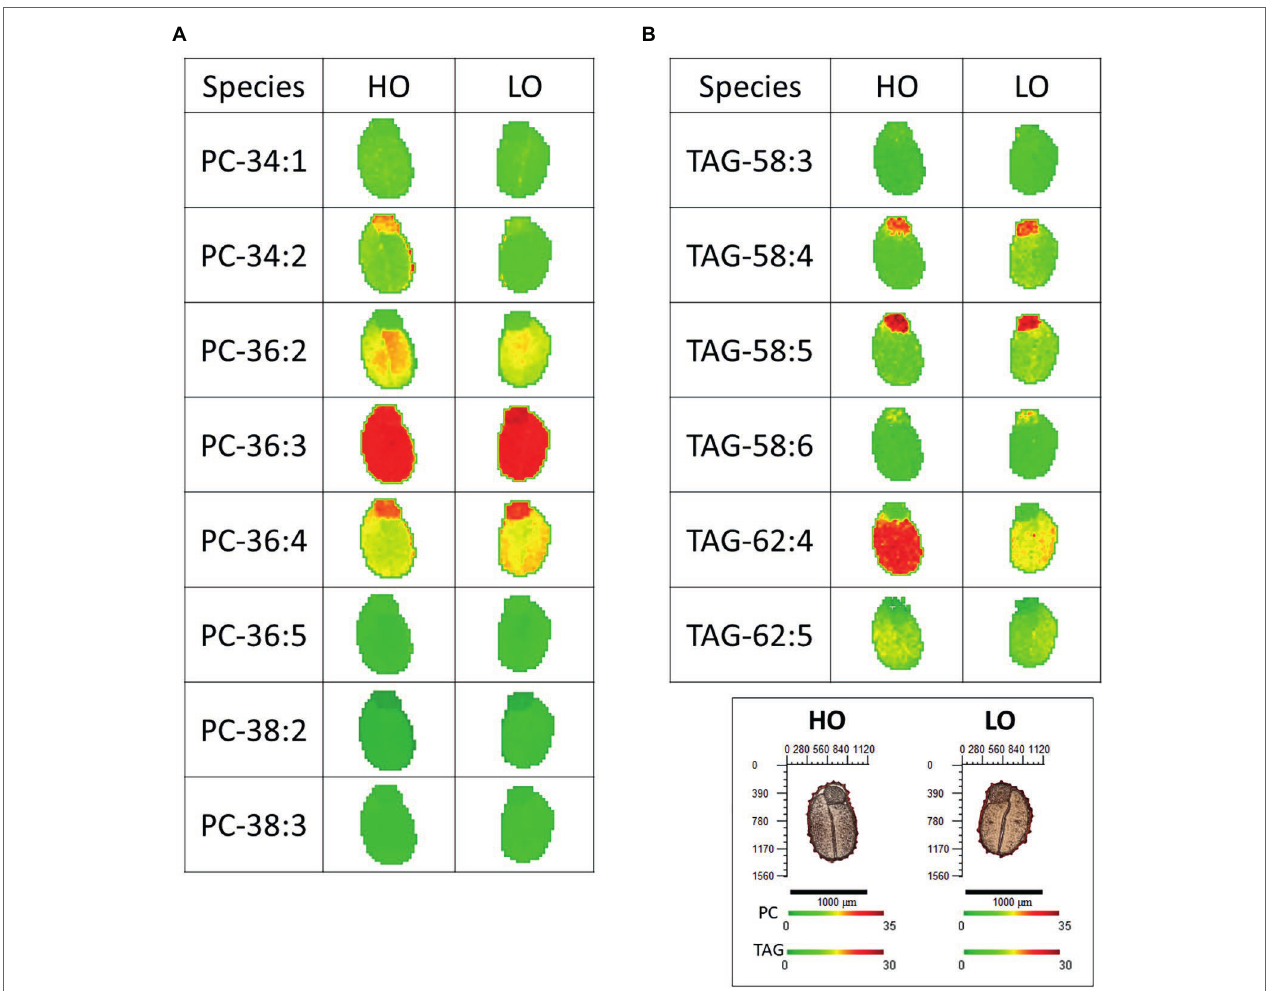
FIGURE 1 | Relative abundance of (A) phosphatidylcholine (PC) and (B) triacylglycerol (TAG) species in high oil (HO) and low oil (LO) accessions of pennycress. Scale bar is 1,000 μ m. Heat scale is normalized to the same intensity across species and accessions within each lipid class to allow for direct comparison. Imaging data was processed using Metabolite Imager (Horn and Chapman, 2014) and plotted as mol% using a colorimetric scale from green (low) to red (high). Images for PC are of the [M + H] + adducts, while TAG are of the sum of [M + Na] + and [M + K] +